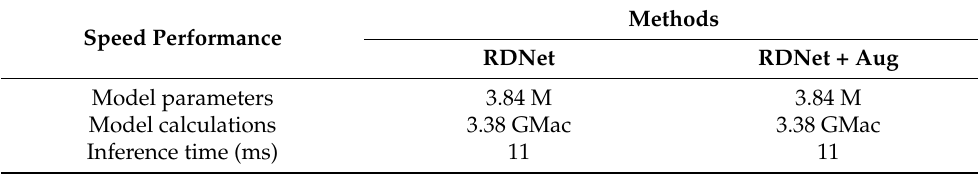
Table 9. Model parameters, calculations, and inference time of RDNet and RDNet + Aug.